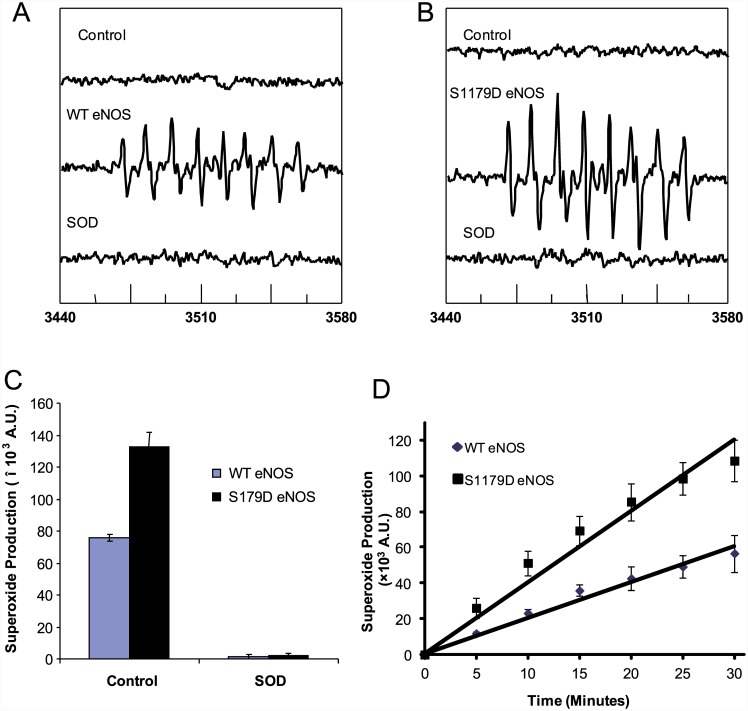
S1179D eNOS has higher rate of O2
-. production than WT eNOS.EPR spectra of oxygen free radicals generated from eNOS. 300nM eNOS was mixed with the reaction system and followed by EPR described in materials and methods. All results shown are the average of four independent experiments.(A) No signal was observed in the reaction system without enzyme (top trace), a prominent spectrum of the DEPMPO-OOH adduct was seen after adding 300 nM WT eNOS (middle trace). These signals were totally abolished by SOD (200 units/ml, bottom trace). (B) 300 nM S1179D eNOS generated a significantly stronger DEPMPO-OOH adduct EPR signal than WT eNOS (middle trace). These signals were also inhibited by SOD (200 units/ml, bottom trace).(C) Total accumulated O2
-. in 30 minute reactions with WT eNOS or S1179D eNOS, showing that S1179D eNOS has a significantly higher rate of O2
-. generation than does WT eNOS. Both reactions were blocked by SOD (200 units/ml). (C) Time course of O2
-. generation by WT eNOS and S1179D eNOS in the reactions described in (C).